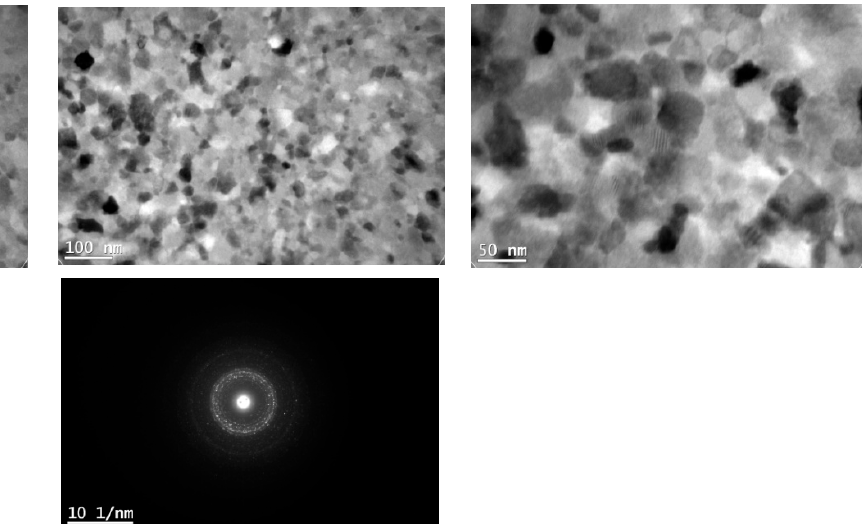
Figure 5. TEM micrograph of Sample 1 and corresponding diffraction pattern.